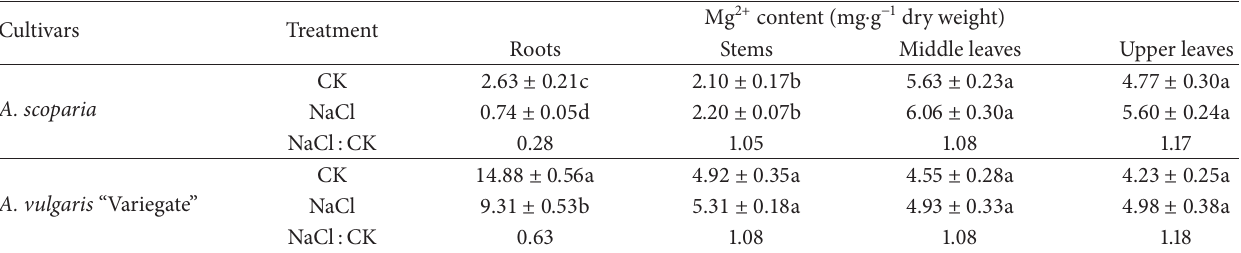
Table 4: Effects of NaCl stress on Mg 2+ content in different organs of A. scoparia and A. vulgaris “Variegate.”